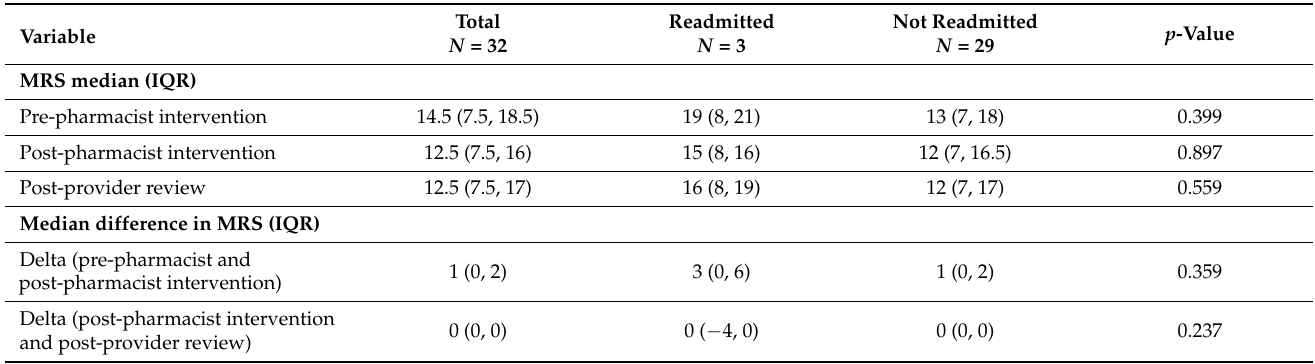
Table 5. Differences in MRS post-pharmacist intervention and post-provider